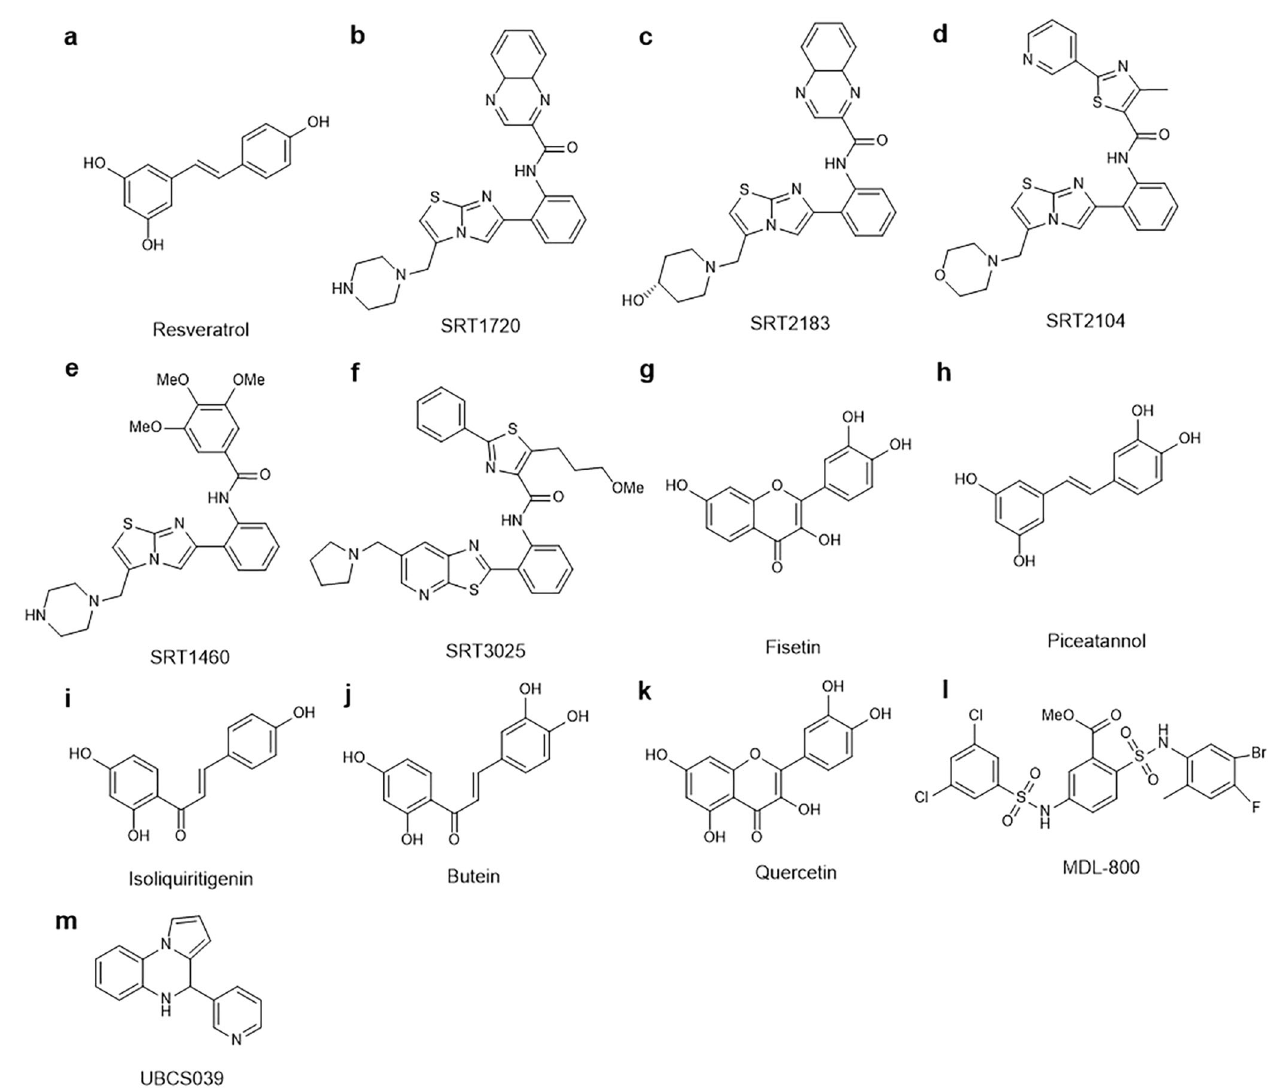
Fig. 16 Structures of most relevant SIRT